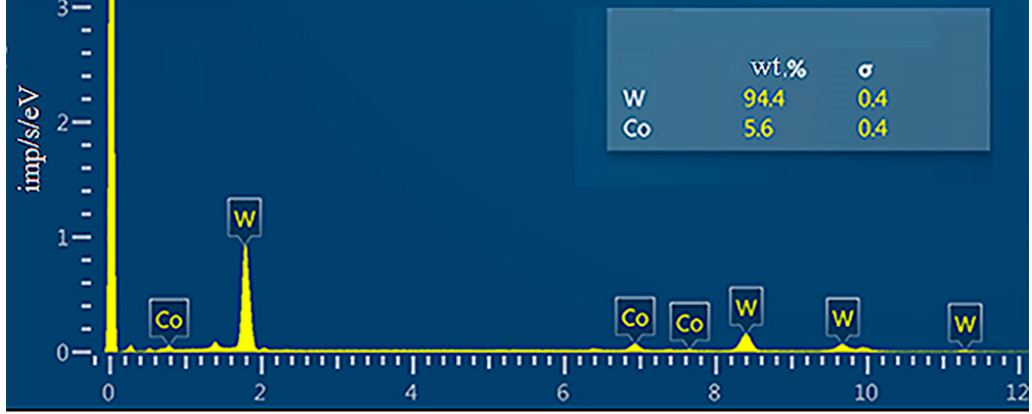
Figure 5. Energy dispersive spectrum of a mixture of micron powder WC and nanopowder Co.